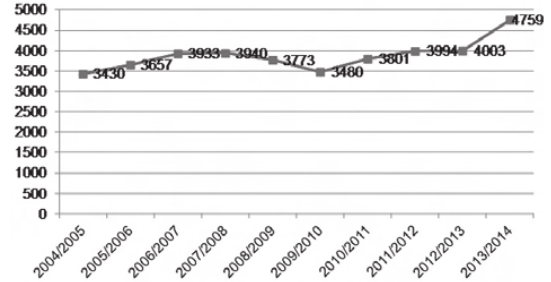
Figure 1: Number of annual vaginal deliveries